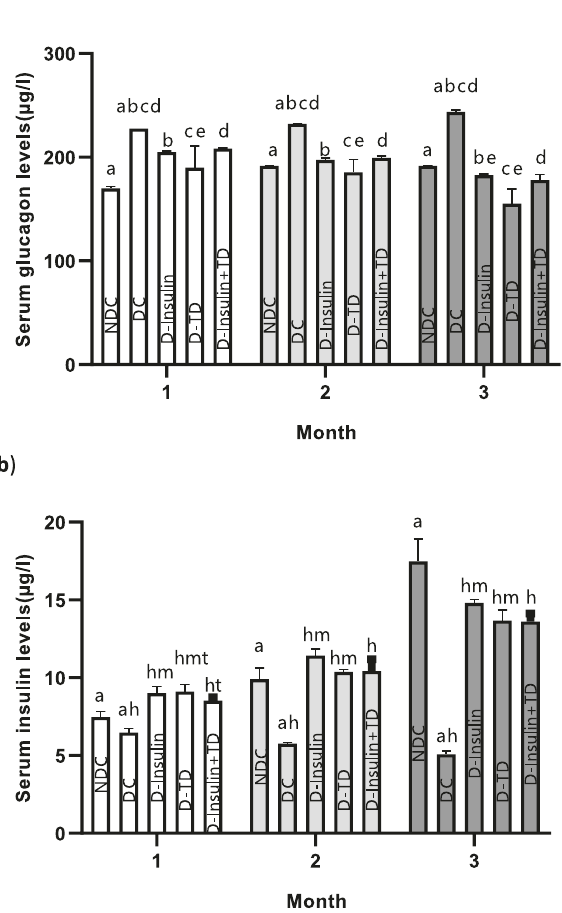
Fig. 5 Effect of TD on changes in serum insulin and glucagon levels in male rats. Comparison of serum glucagon levels ( a ) and serum insulin levels ( b ) over three months in the non-diabetic control (NDC), diabetic control (DC), D-insulin, D-TD, and D-insulin + TD groups. The DC group received 60 mg/kg STZ. D-insulin treated with 2.5 U/kg insulin twice per day (1/3 morning and 2/3 in the evening), D-TD group treated with daily IP injection of 40 mg/kg thiamine disul fi de, D-insulin + TD group treated with TD and insulin (2.5 U/kg insulin + 40 mg/kg TD once per day). Data are expressed as mean ± S.E.M ( N = 7). a Signi fi cant difference between NDC and DC groups ( p < 0.0001) during the three months for serum glucagon levels. b Signi fi cant difference between the DC and D-insulin groups ( fi rst month: ( p < 0.01), second month ( p < 0.001), third month ( p < 0.0001)) for serum glucagon levels. c Signi fi cant difference between the DC and D-TD groups ( fi rst month: ( p < 0.01), second month ( p < 0.001), third month ( p < 0.0001)) for serum glucagon levels. d Signi fi cant difference between the DC and D-insulin + TD groups ( fi rst month: ( p < 0.001), second month ( p < 0.001), third month ( p < 0.0001)) for serum glucagon levels. e Signi fi cant difference between the D-insulin and D-TD groups ( p < 0.001) during the three months for serum glucagon levels. f Signi fi cant difference between the D-TD and D-insulin + TD groups ( p < 0.001) during the three months for serum glucagon levels. r Signi fi cant difference between the NDC and DC groups ( fi rst month: ( p < 0.01), second month ( p < 0.001), third month ( p < 0.0001)) for serum insulin levels. h Signi fi cant difference between the DC group and (D-insulin, D-TD and D-insulin + TD groups ( fi rst month: ( p < 0.01), second month ( p < 0.001), third month ( p < 0.0001)) for serum insulin levels. m Signi fi cant difference between the D-insulin and D-TD groups ( fi rst and second months ( p < 0.05)) for serum insulin levels. t Signi fi cant difference between the D-TD and D-insulin + TD groups ( fi rst month: ( p < 0.01)) for serum insulin levels.